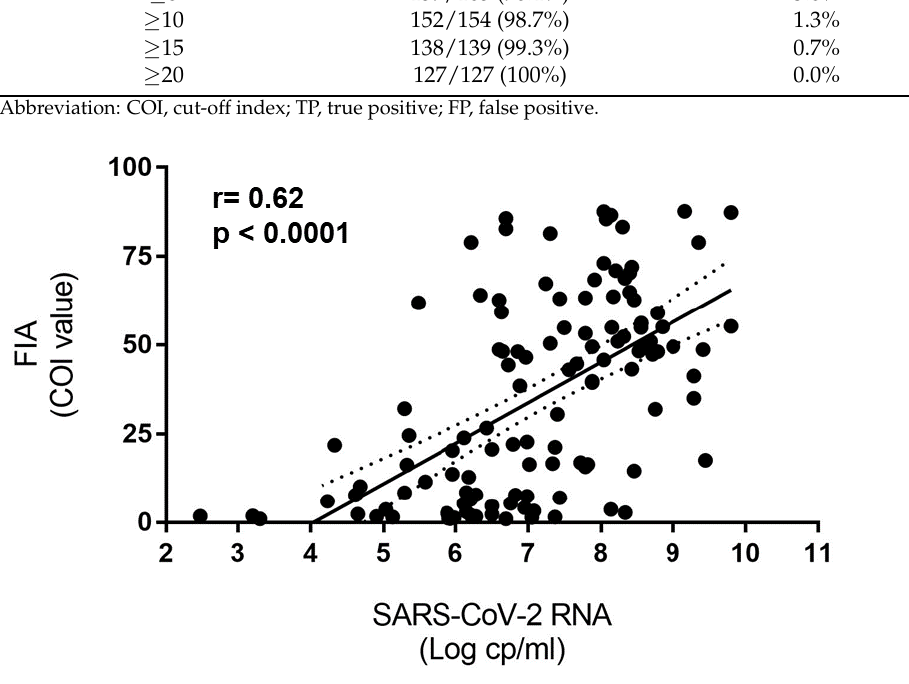
Figure 2. Correlation between SARS-CoV-2 RNA copies number and COI obtained on confirmed SARS-CoV-2 positive samples with available information for both parameters ( n = 125, as in blue box of Figure 1).